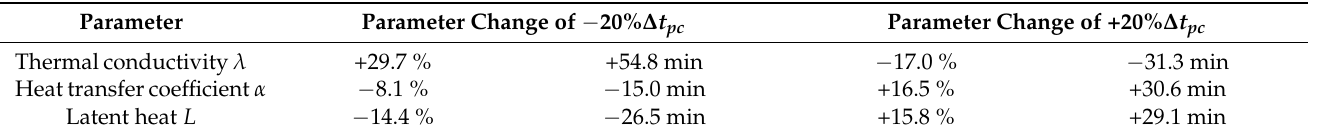
Table 2. Parameter study: Influence of different parameters on the melting time t pc . The change of the melting time ∆ t pc refers to the enhanced model with t pc = 184